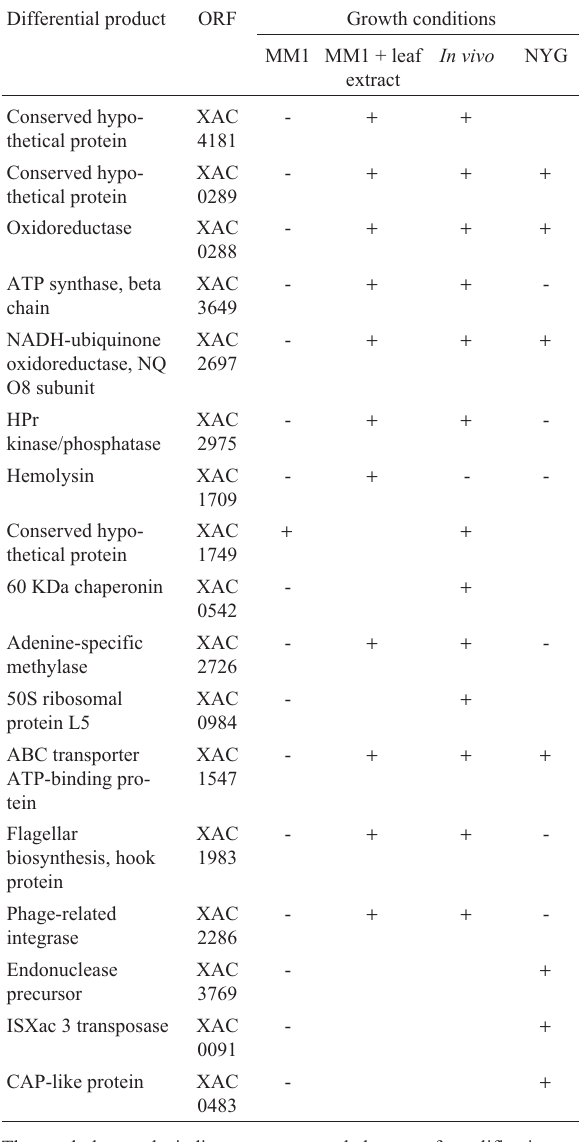
Table 3 - RT-PCR results for the 17 selected genes using cDNA of the bacterium grown in MM1, MM1 + leaf extract, in vivo and in NYG. Differential